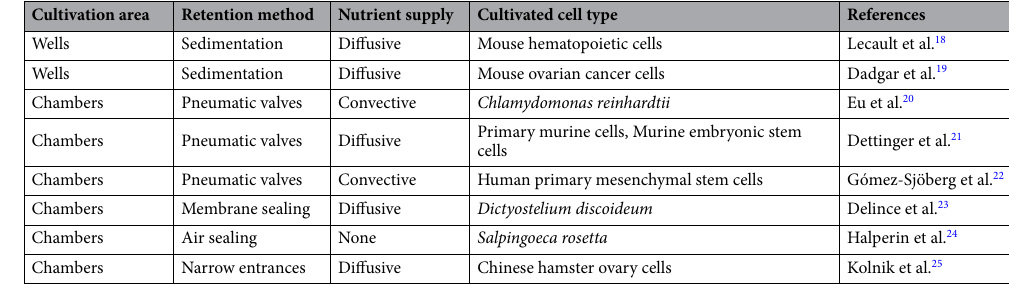
Table 1. Overview of recently published microfluidic cultivation devices with enhanced cell retention. The listed approaches are itemized concerning the characteristics of the respective cultivation area, the cell retention method, and the nutrient supply. Additionally, the cultivated cell type is